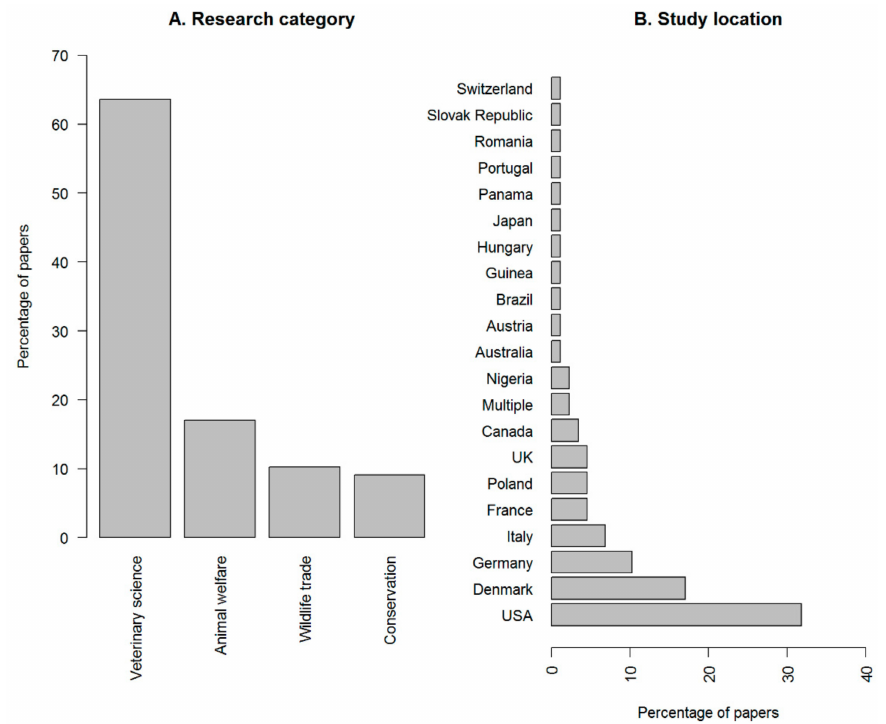
Figure 1. Percentage of papers per research focus category ( A ), and by location of study ( B ). Total number of papers included n =